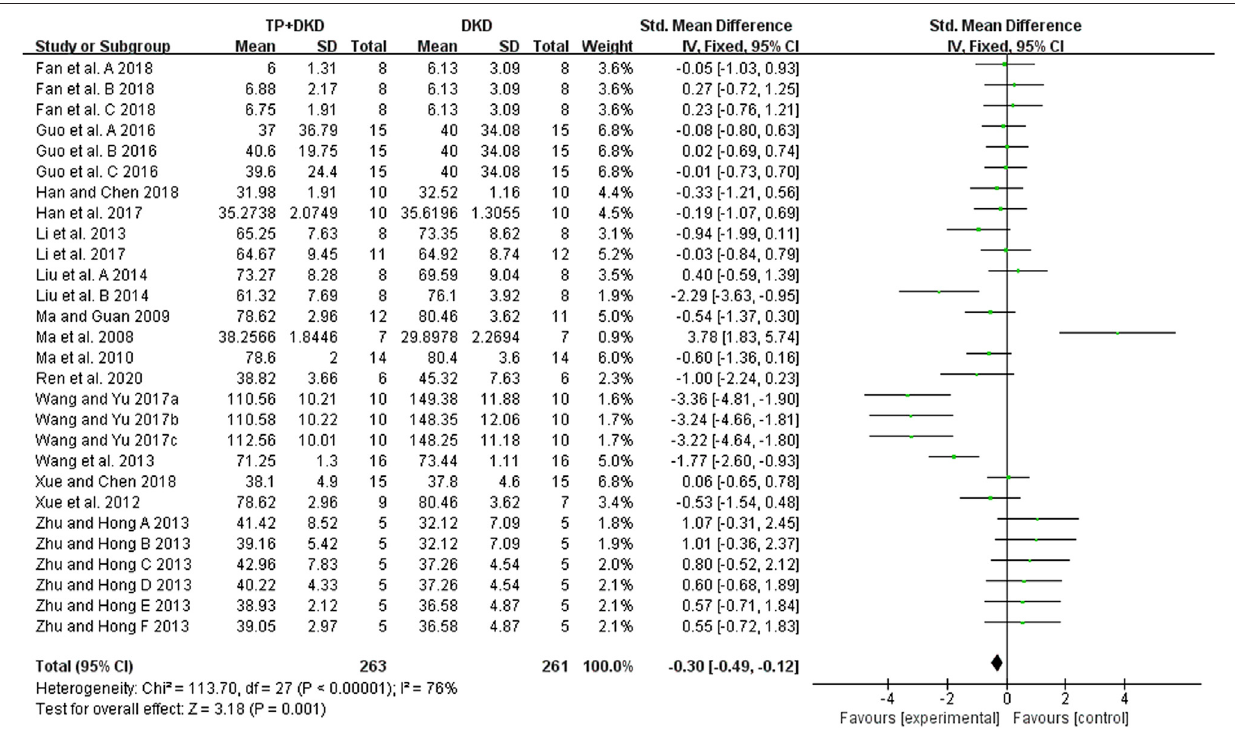
FIGURE 7 | Forest plot of SCr outcome.